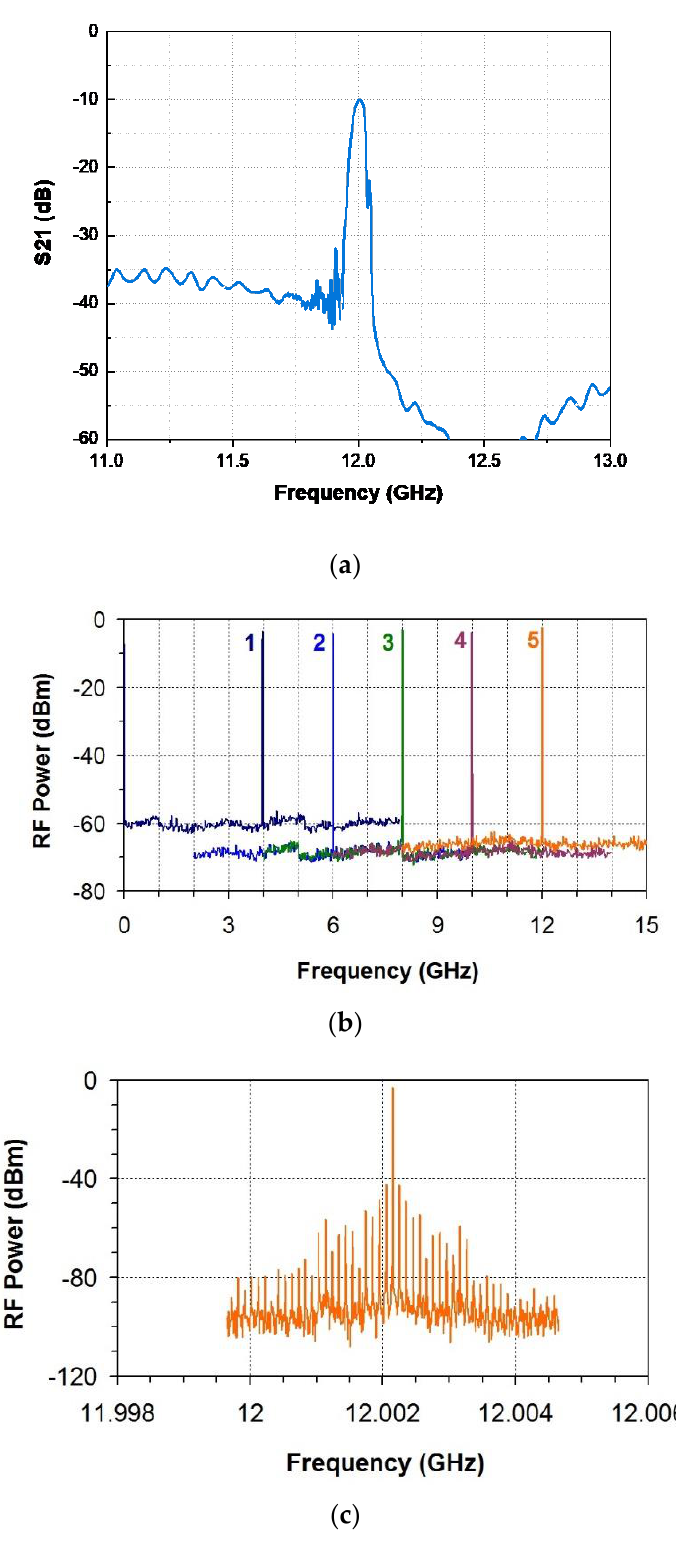
Figure 5. ( a ) Typical frequency transfer function of the open-loop configuration with the YIG film spin-wave filter, tuned at 12 GHz. ( b ) Superimposed generation spectra, obtained for OEO configuration with the broadband demodulation for different settings of the YIG filter. ( c ) Similar generation spectrum observed for tuning of the YIG film filter to 12 GHz and presented with higher resolution.